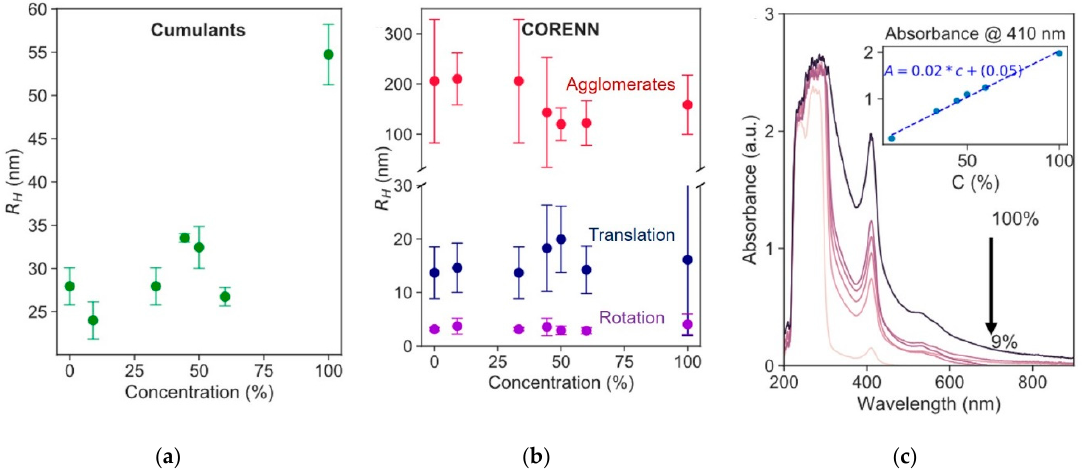
Figure 3. Filtered mouse serum at various concentrations (9%, 33%, 44%, 50%, 60%, 100%) ( a ) Cumulants; ( b ) hydrodynamic radii based on CORENN; at 9% the R H values as obtained at 33% concentration are confirmed ( a , b ); as an estimate of a zero-concentration limit the experimental value obtained at 33% concentration is thus chosen and indicated again at 0% in ( a , b ); ( c ) optical NIR-vis-UV spectra at various concentration ( c adapted from [10]).